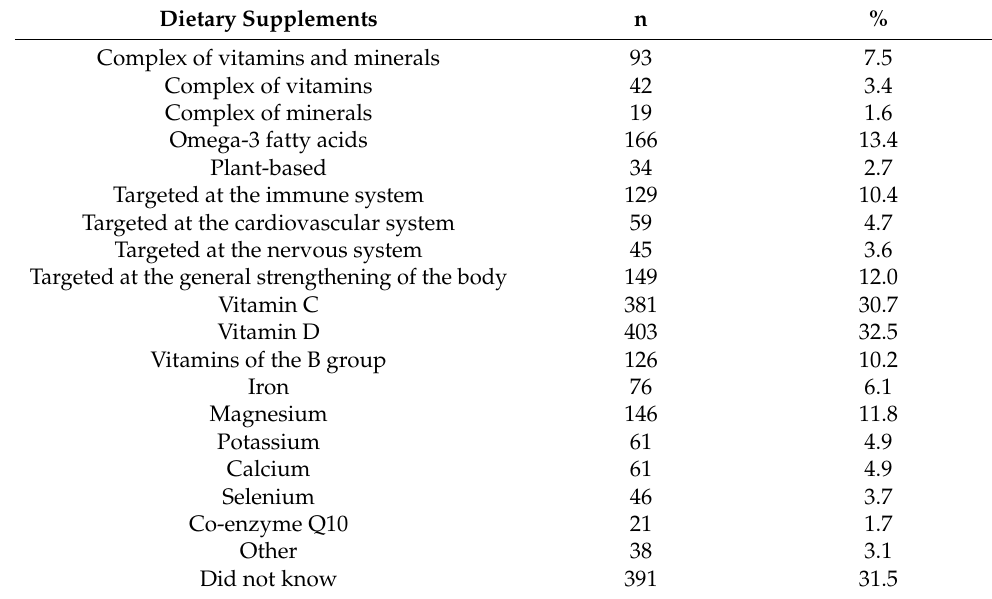
Table 4. Distribution of the respondents by an increase in the consumption of dietary supplements during the COVID-19 pandemic by exact dietary supplements among the respondents who consumed dietary supplements (n =